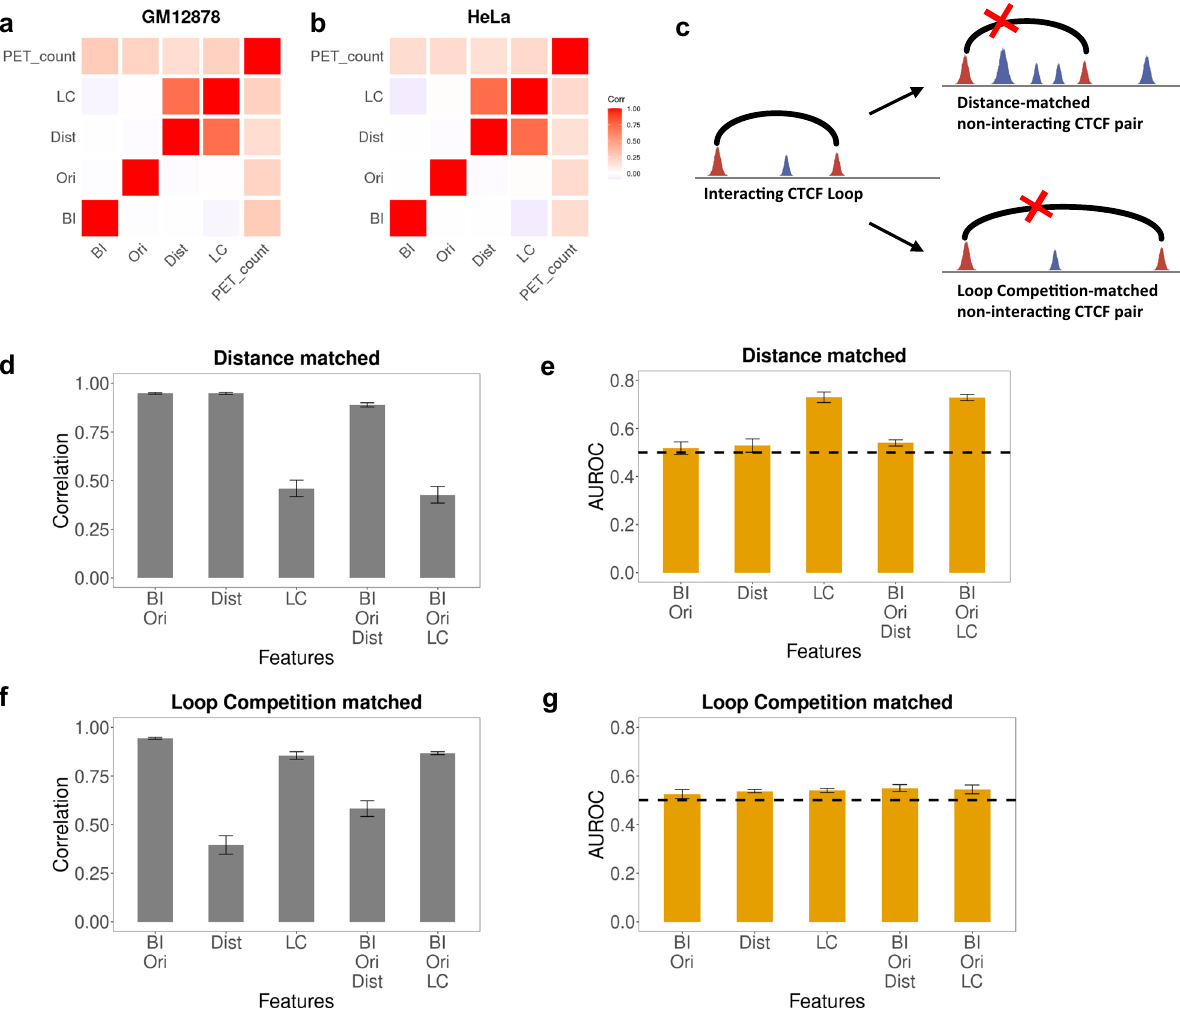
Fig. 5 Loop competition is a more crucial determinant than distance. a , b Correlation of features (CTCF-binding intensity, CTCF motif orientation, distance, loop competition (LC) and PET count (log scale)) across all positive and negative pairs. Since loop competition and distance are correlated, we designed an additional experiment to isolate their relative informative value. c We generated distance-matched and loop competition-matched subsets of the full data by choosing a negative pair (marked with X) for each positive pair with either LC or distance matched within a factor of two. d , f Correlation between positive and negative sets for different combinations of features in both matched settings. e , g AUROC of loop extrusion model with different combinations of features in both settings. Down sampling of 10% of the data was repeated 10 times and 95% con fi dence intervals are shown. Since LC adds informative value in a distance matched evaluation set but the converse is not true, loop competition is the more predictive